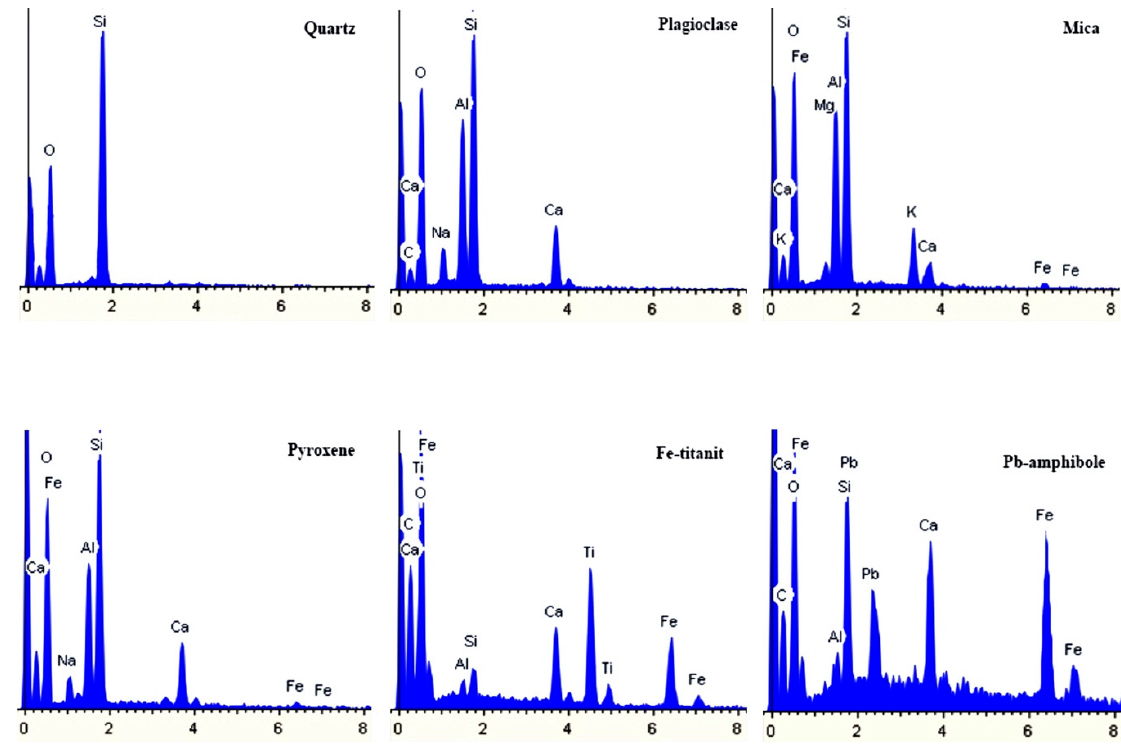
Figure 3. Examples of EDX-spectra of silicate minerals grains in a biofilm with a predominance of microscopic fungi on the surface of a homogeneous calcite marble.